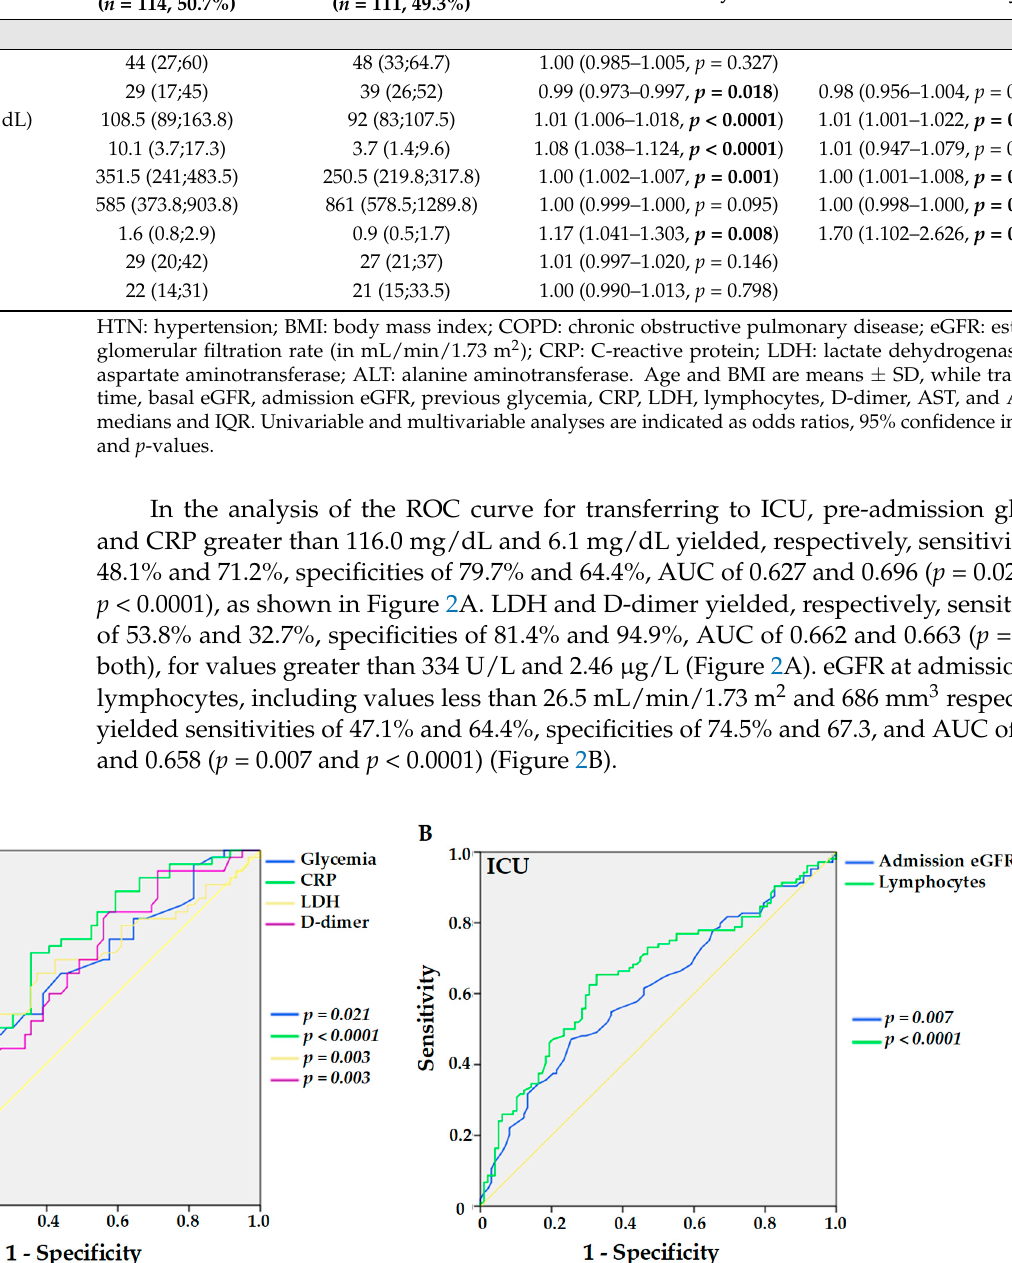
Figure 2. Sensitivities and specificities of higher levels of previous glycemia ( p = 0.021), C-reactive protein (CRP, p < 0.0001), lactate dehydrogenase (LDH, p = 0.003), and D-dimer ( p = 0.003) ( A ), and lower levels of estimated glomerular ratio (eGFR) at admission ( p = 0.007) and lymphocytes ( p < 0.0001) ( B ) in hypertensive kidney transplant recipients with COVID-19 for the outcome of transferring to the ICU.